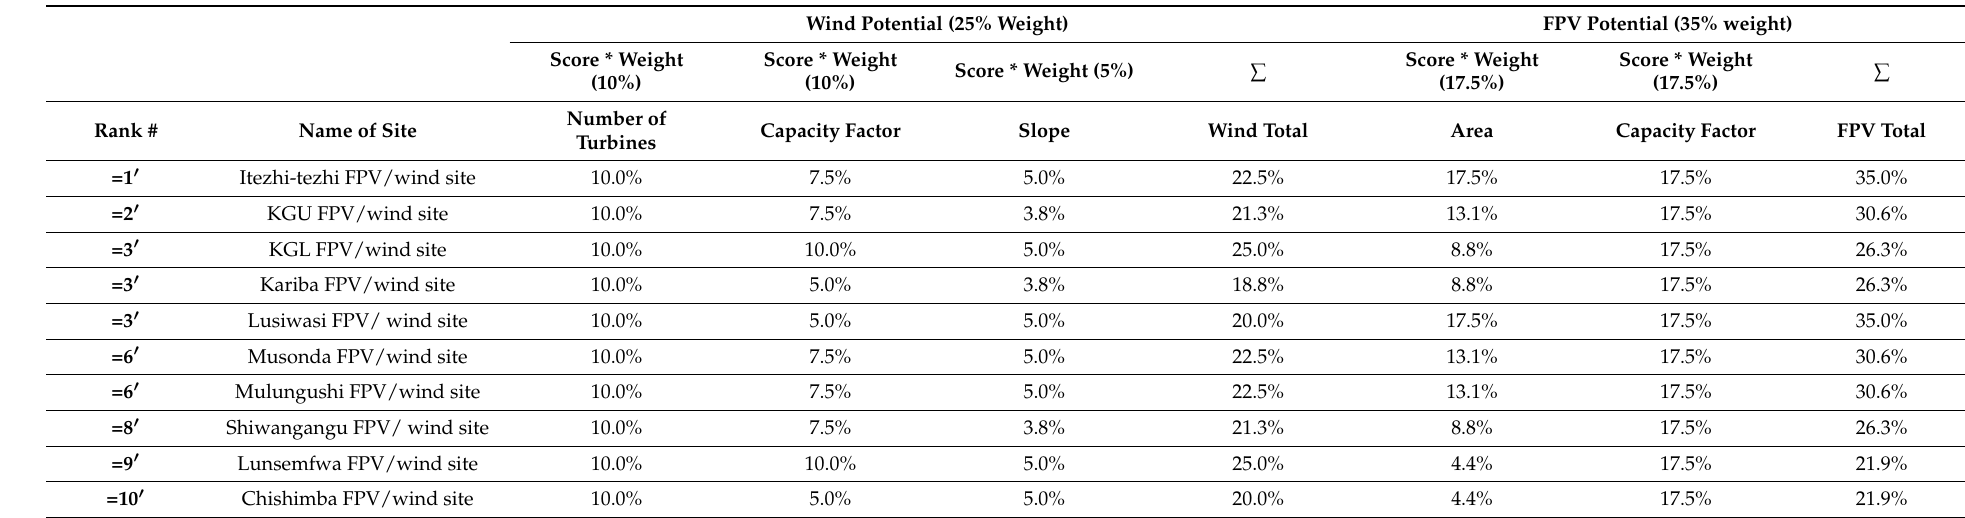
Table A2. Showing balanced scoring and ranking matrix